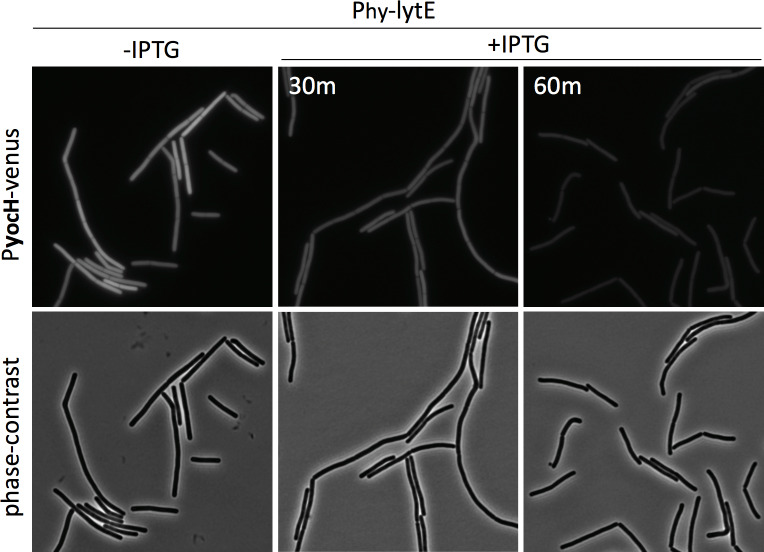
PyocH-venus transcription decreases in response to LytE over-expression.Representative fluorescence and phase-contrast images of cells harboring the PyocH-venus reporter and the strong IPTG-inducible promoter fusion to lytE (Phy-lytE). Cells were grown in LB medium to an OD600 of ~0.3 and were visualized before and at indicated times after the addition of 50 µM IPTG.